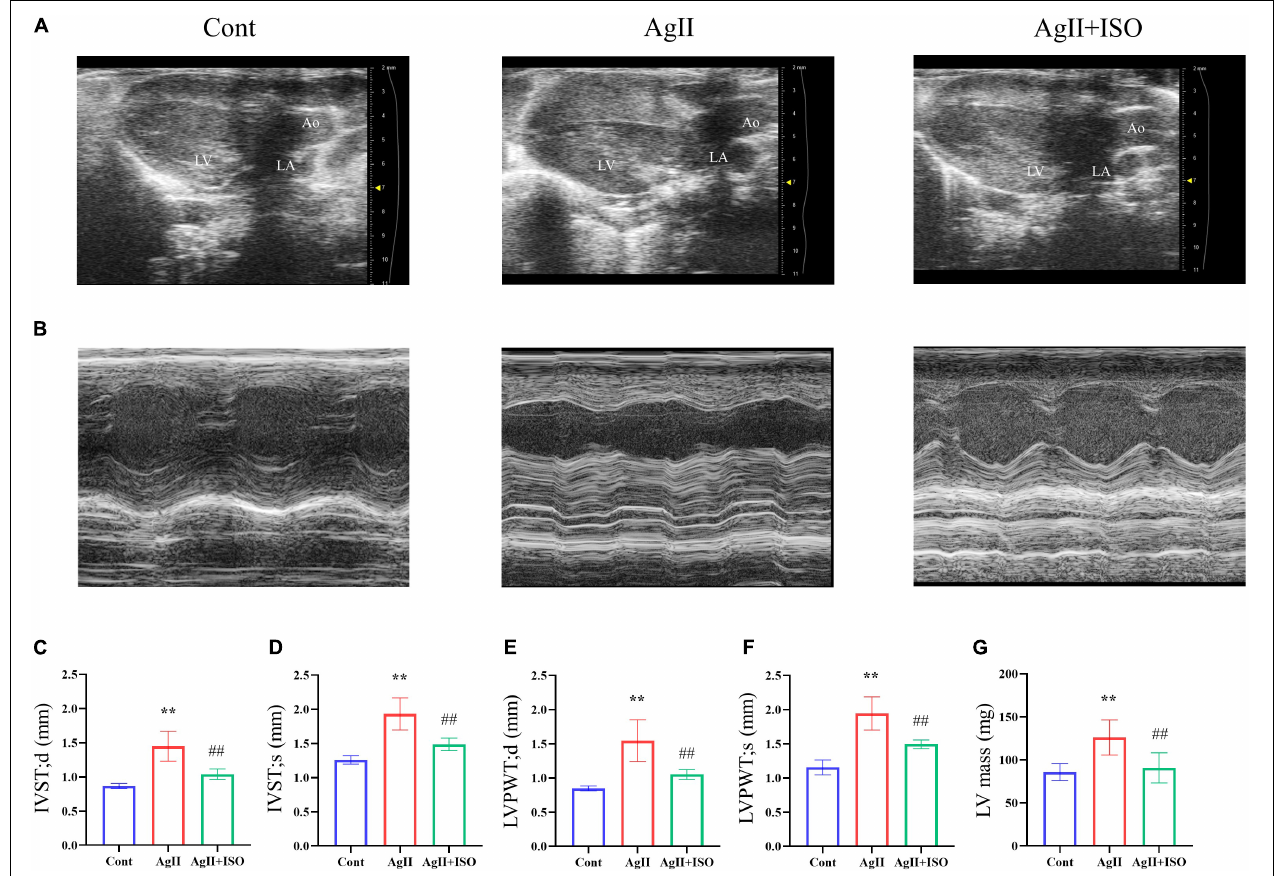
FIGURE 2 | (A,B) Representative B-mode and M-mode echocardiograms of 11-week-old mice from the three groups. (C–G) Echocardiographic parameters, including IVS-s, IVS-d, LVPW-s, LVPW-d, and LV mass. Data were evaluated at 11 weeks in the Cont, AgII, and AgII + ISO groups ( n = 5–7 per group). ** P < 0.01 vs. Cont. ## P < 0.01 vs. AgII + ISO. IVST-s, LV interventricular septal thicknesses in systole; IVS-d, LV interventricular septal thickness in diastole; LVPWT-s, LV posterior wall thickness in systole; LVPWT-d, LV posterior wall thickness in diastole; LV, left